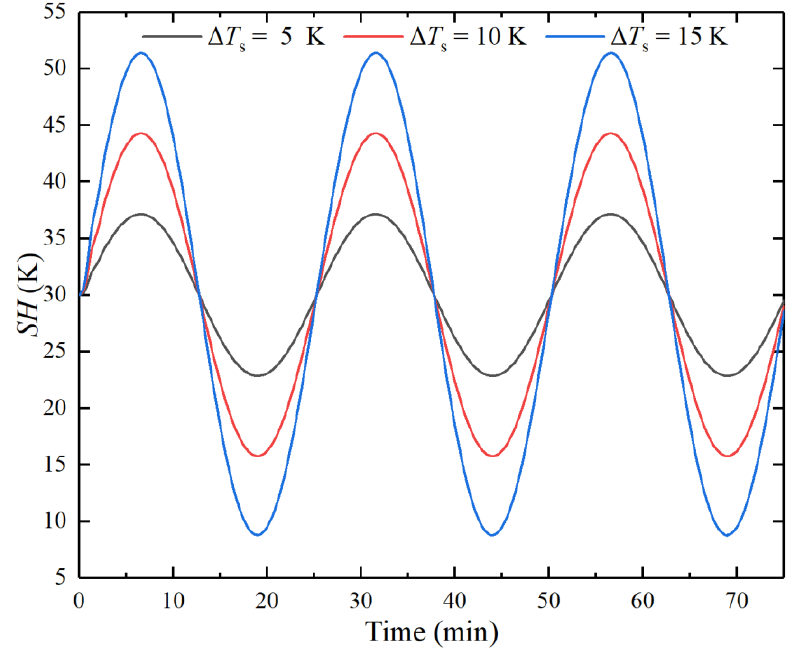
Figure 11. Effect of heat-source temperature on the superheat degree.